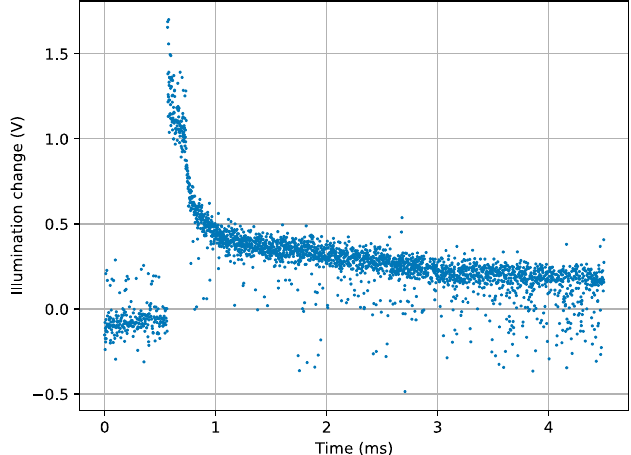
Figure 8. Illumination differences of 4000 pixels read in a period of 1.12 µs. The event (LED switching on) is introduced after Pixel 500 (0.560 ms).